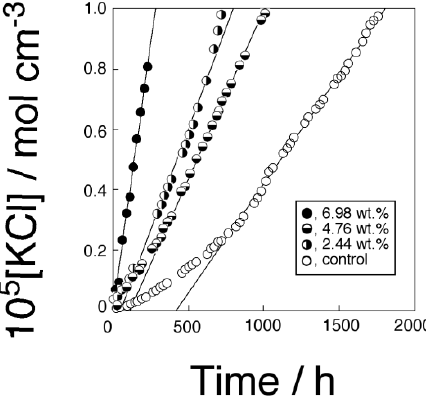
Figure 3. Time-transport curves of KCl through the PC18AAm liquid